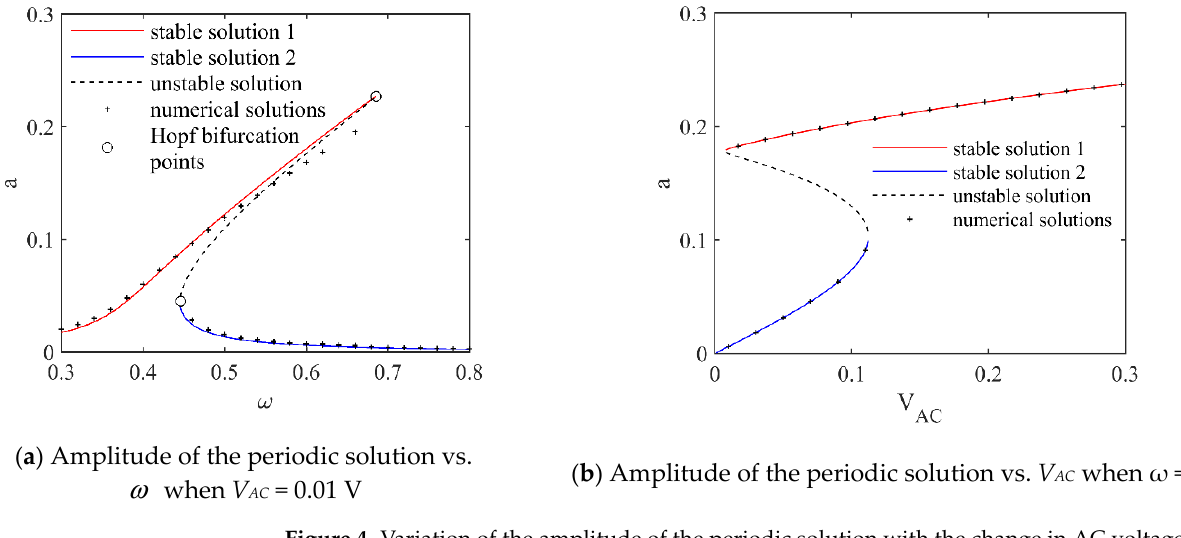
Figure 4. Variation of the amplitude of the periodic solution with the change in AC voltage.